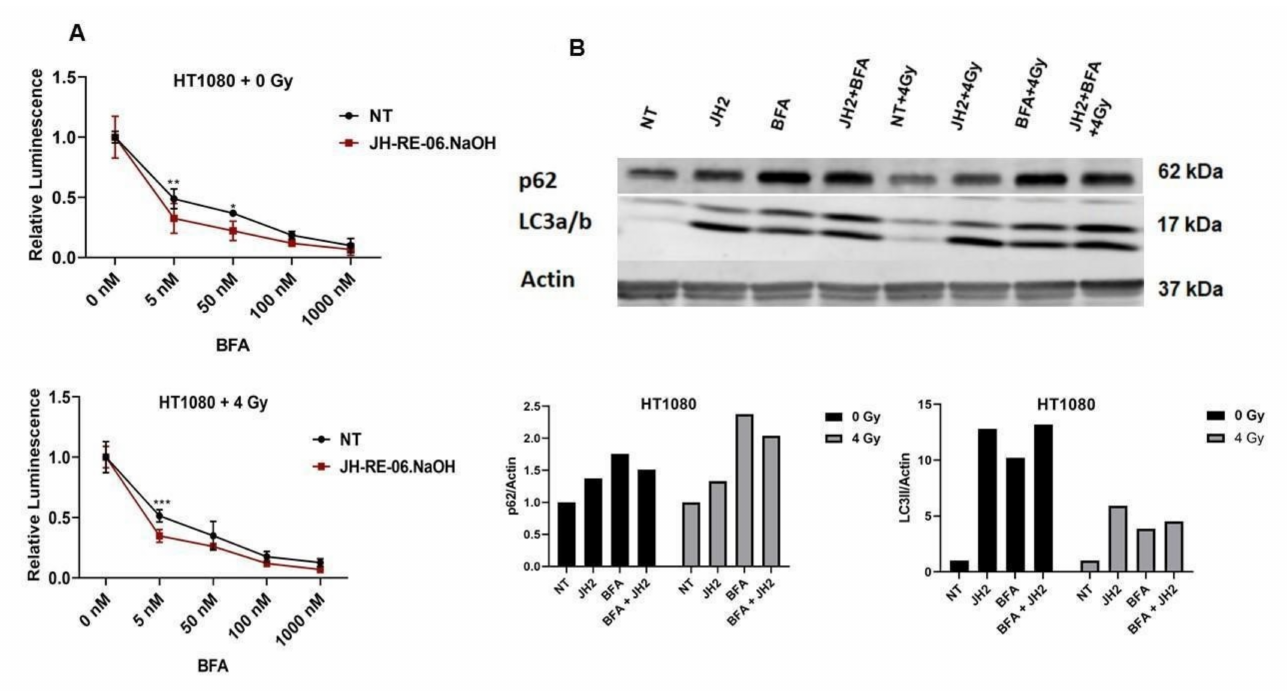
Figure 4. Autophagy inhibition has a narrow range for sensitizing cancer cells treated with ionizing radiation and REV1 inhibitors. ( A ) Graphs show relative luminescence in HT1080 cells treated with 0 or 4 Gy ionizing radiation in the presence of increasing doses of autophagy inhibitor BFA and 1 uM of JH-RE-06.NaOH. ( B ) Representative Western blot images show expression patterns of p62 and LC3a/b in HT1080 cells treated with JH-RE-06.NaOH at 1 mM, BFA at 50 mM, and ionizing radiation at 0 and 4 Gy, respectively. Graphs show relative quantification of p62 and LC3a/b expression in HT1080 cells from the Western blots above. p -Values are * p < 0.05, ** p < 0.01, and *** p < 0.001. Error bars represent standard deviations. p values were calculated by 2-way ANOVA. N = 6 for all